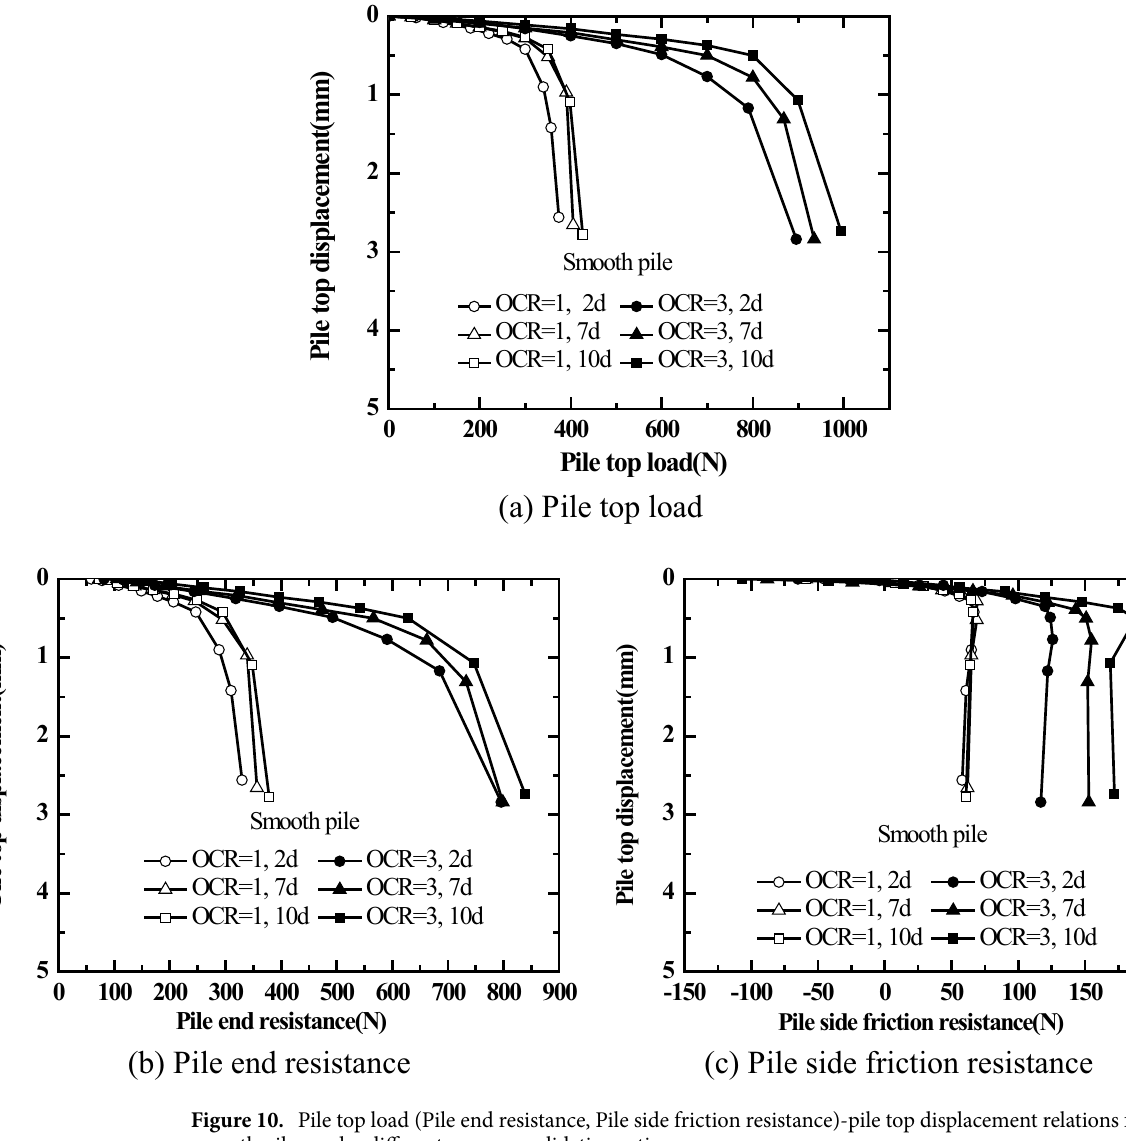
Figure 10. Pile top load (Pile end resistance, Pile side friction resistance)-pile top displacement relations for smooth piles under different over-consolidation